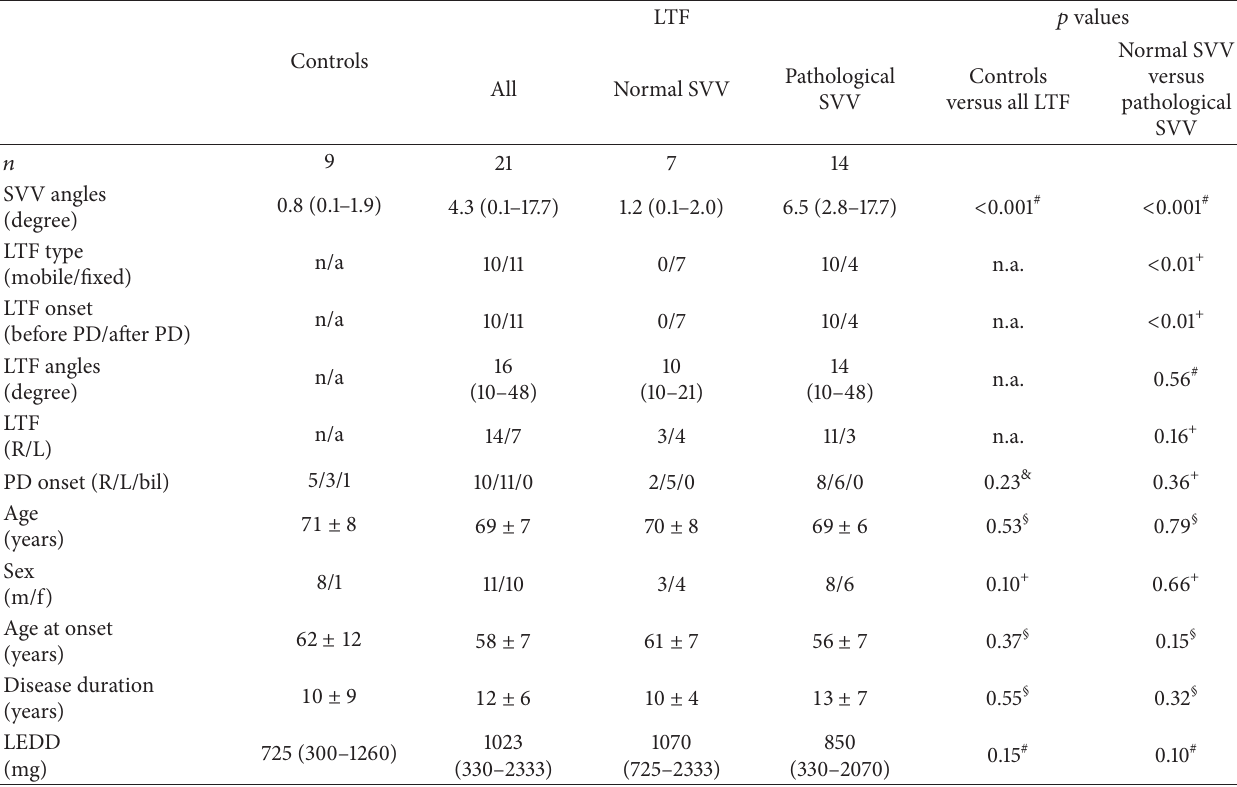
Table 1: Comparison of clinical features and demographic factors in PD patients with and without LTF (controls) and PD patients with LTF. LTF 𝑝 values Controls Pathological versus Normal SVV pathological